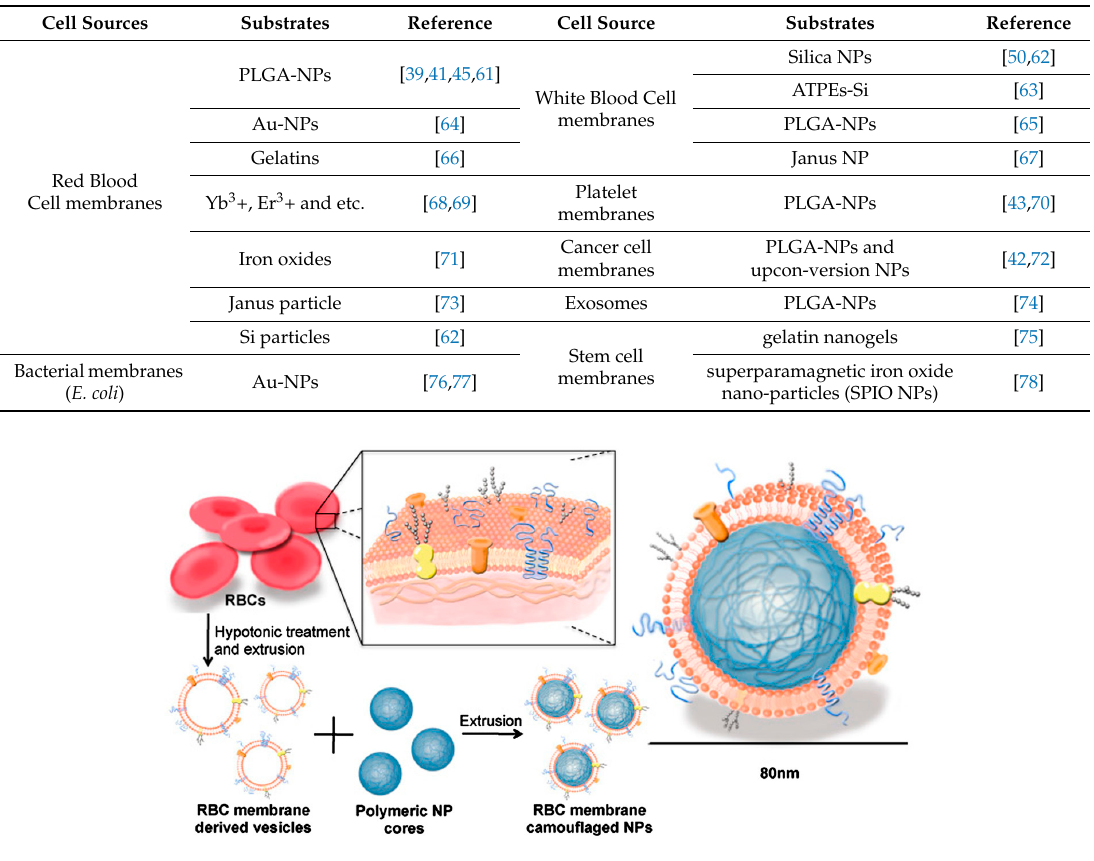
Figure 2. The schematics for the preparation process for RBC-membrane-coated PLGA NPs. RBC membrane-coated NPs are prepared using an extrusion-based fusion process between the osmotic shock-derived RBC membranes and the nano-sized PLGA particles. Adapted with permission from [39] copyright 2011, Proceedings of the National Academy of Sciences.